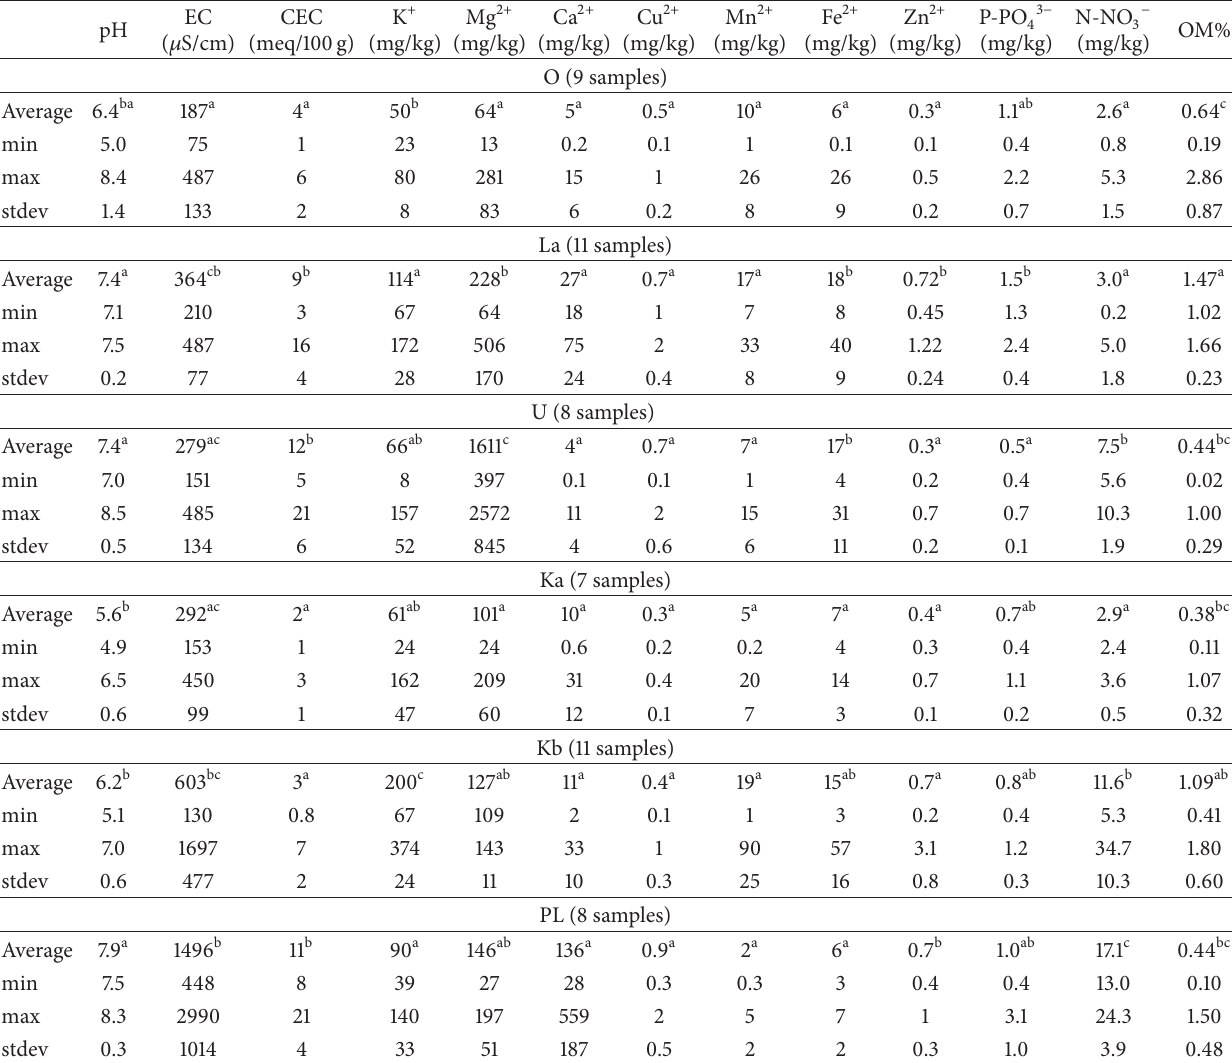
Table 3: Average values in soils from investigated areas for pH, electrical conductivity, CEC, macronutrients (Mg 2+ , Ca 2+ , K + , NO 3− , PO 43− ) , micronutrients (Cu 2+ , Mn 2+ , Fe 2+ , Zn 2+ ) , and organic matter (OM). Standard deviation, minimum, and maximum are also presented. Identical letters in the same column denote no statistical difference in average values according to t -test with alpha coefficient